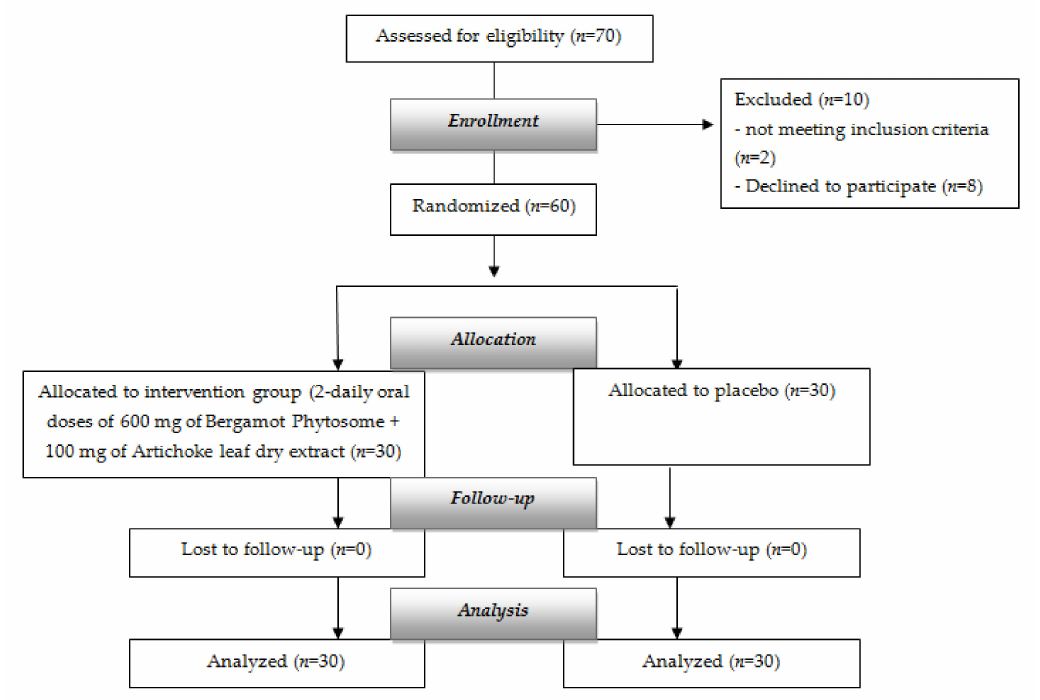
Figure 1. Flow diagram of the